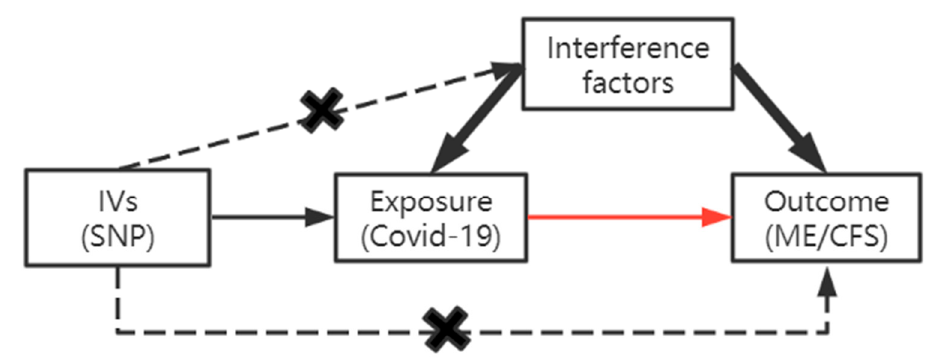
Figure 1. TSMR Figure 1. TSMR model.